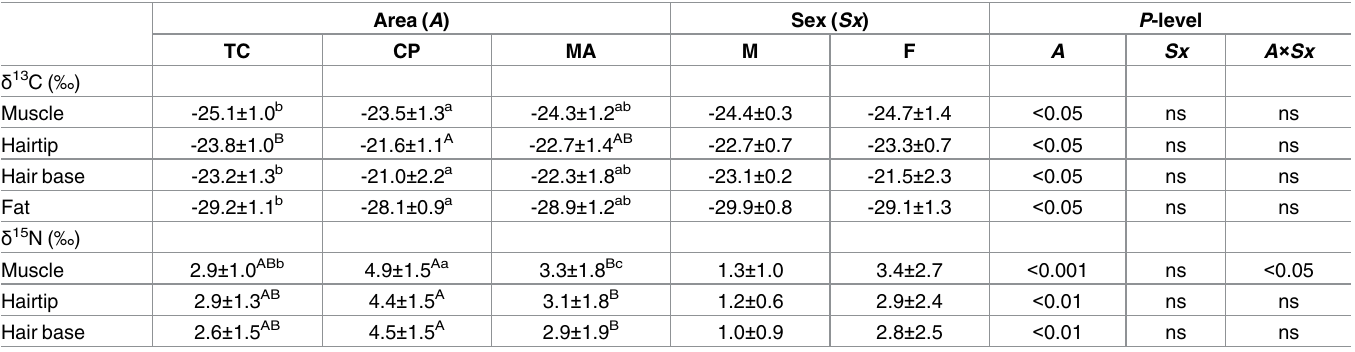
Table 3. Effect of the area of harvestand gender on δ 15 N and δ 13 C (mean ± SD) in muscle, hair tip, hair base, and fat of free-living wild